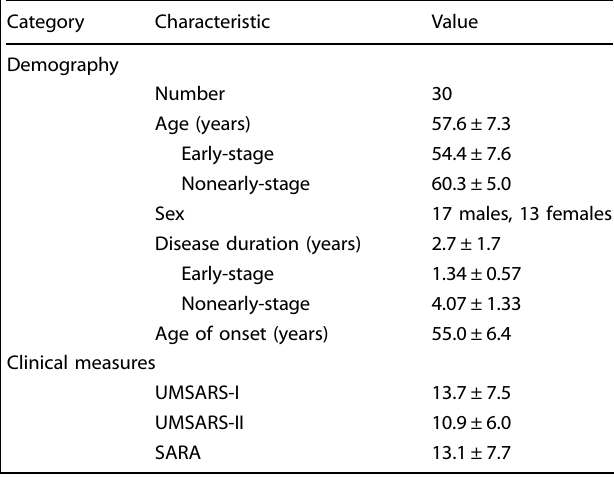
Table 1. Demographic characteristics and clinical measures of MSA-C